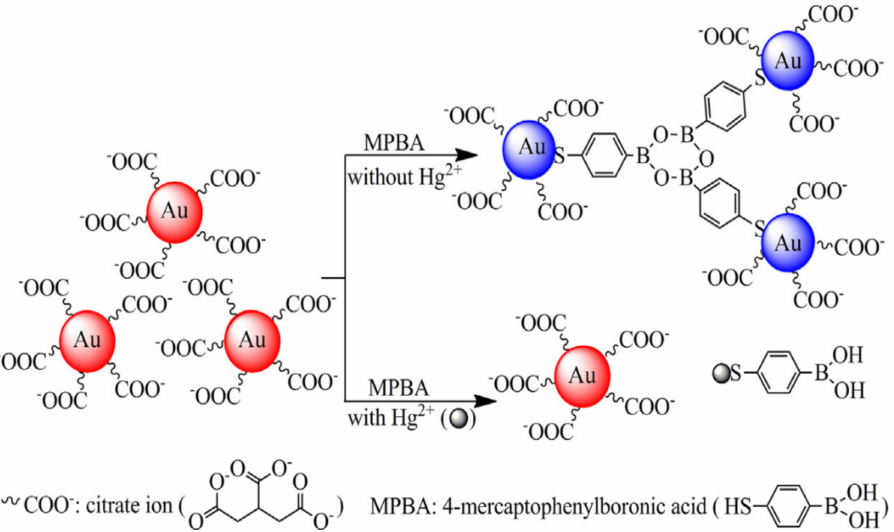
Figure 3. Schematic presentation of the MPBA/AuNPs colorimetric mechanism for Hg 2+ detec- tion [61]. Reproduced with permission from Zhou et al., Sensors Actuators, B Chem. published by the Elsevier B.V.,